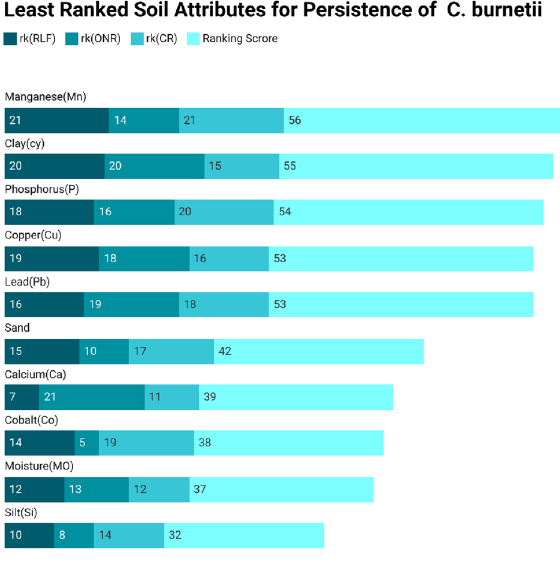
Figure 4. Individual and Aggregate Score of Least Ranked attributes of C. burnetii Soil dataset using Feature- ranking